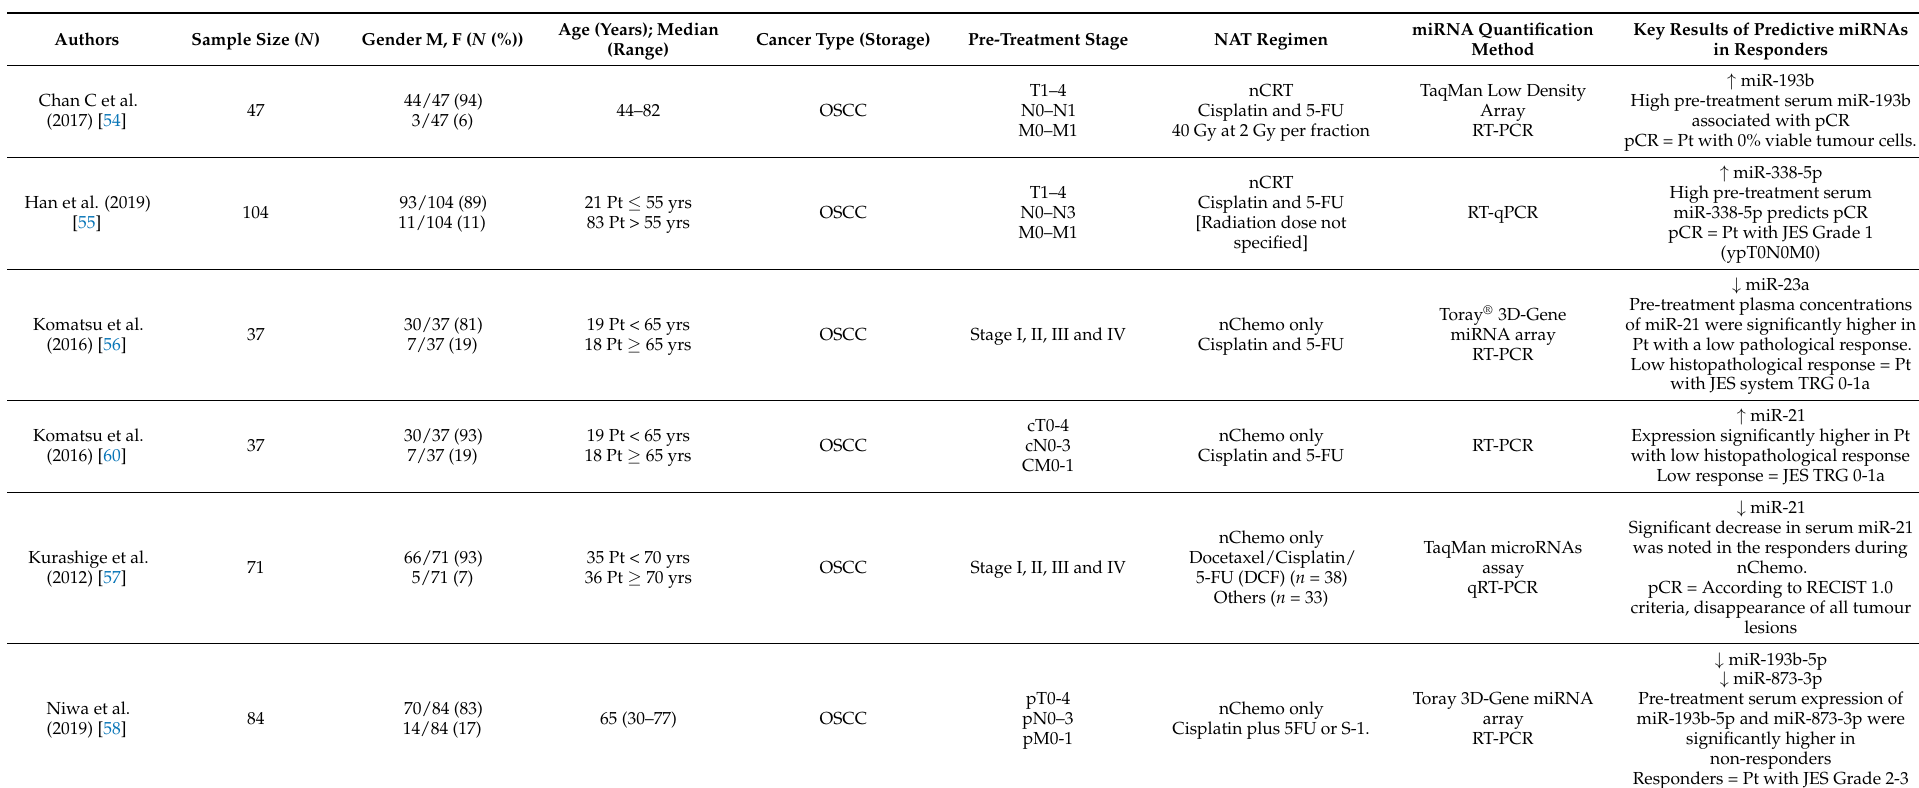
Table 2. Articles studying the utility of miRNAs in pre-treatment OSCC samples to predict response to